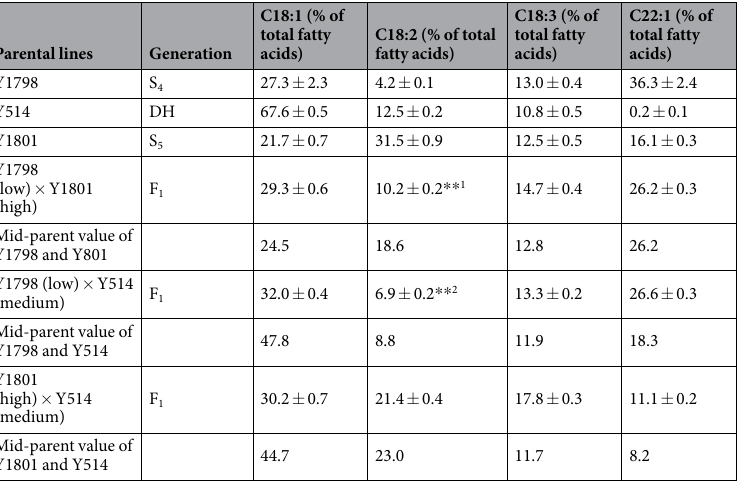
Table 1. Fatty acid profile of the parental lines Y1798, Y514 and Y1801, F 1 seeds, and mid-parent value in yellow mustard. Fatty acid content is expressed as mean value ± standard deviation. ** Statistical significant difference at p = 0.01 level. 1 Comparison between F 1 and mid-parent value of Y1798 and Y1801; 2 Comparison of F 1 and mid-parent value of Y1798 and